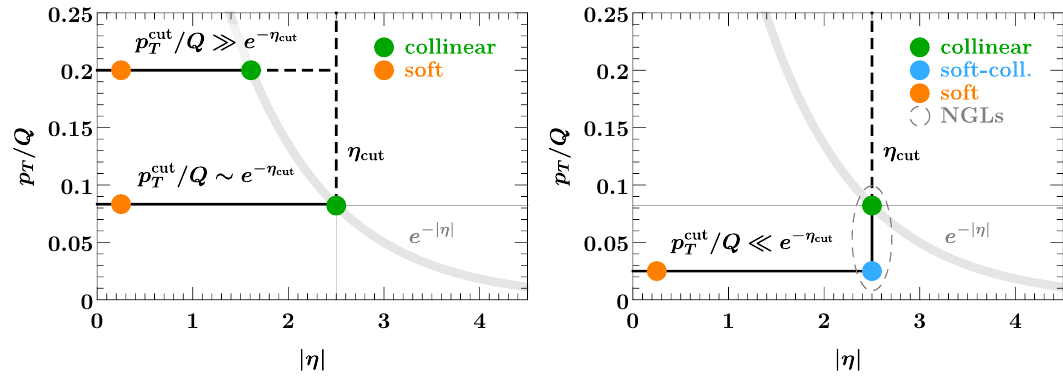
Figure 2 . Illustration of the parametric regimes for a jet veto with a jet rapidity cut. Emissions above the black solid lines are vetoed as p T > p cut up to (cid:17) < (cid:17) cut = 2 : 5. The thick gray line T j j corresponds to p T =Q = e (cid:0)j (cid:17) j , and emissions above and to the right of it are power suppressed. The colored circles indicate the relevant modes in the e(cid:11)ective theory for a given hierarchy between p cut =Q and e (cid:0) (cid:17) cut . For p cut = 25 GeV, the given examples for p cut =Q correspond to Q = 125 GeV T T T (left panel, upper case), Q = 300 GeV (left panel, lower case), Q = 1 TeV (right